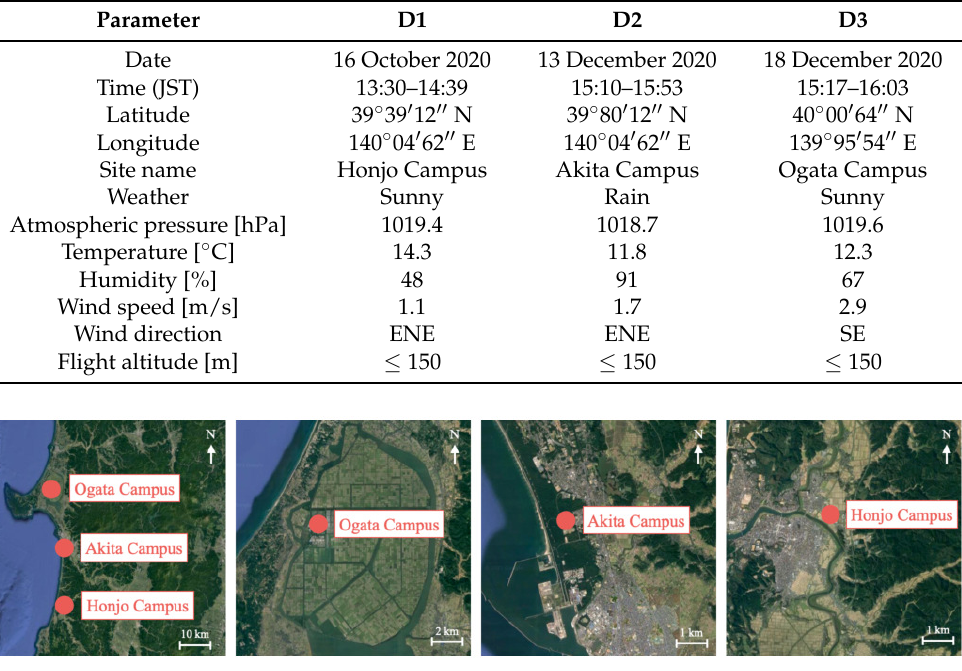
Figure 19. Locations of the respective campuses and their